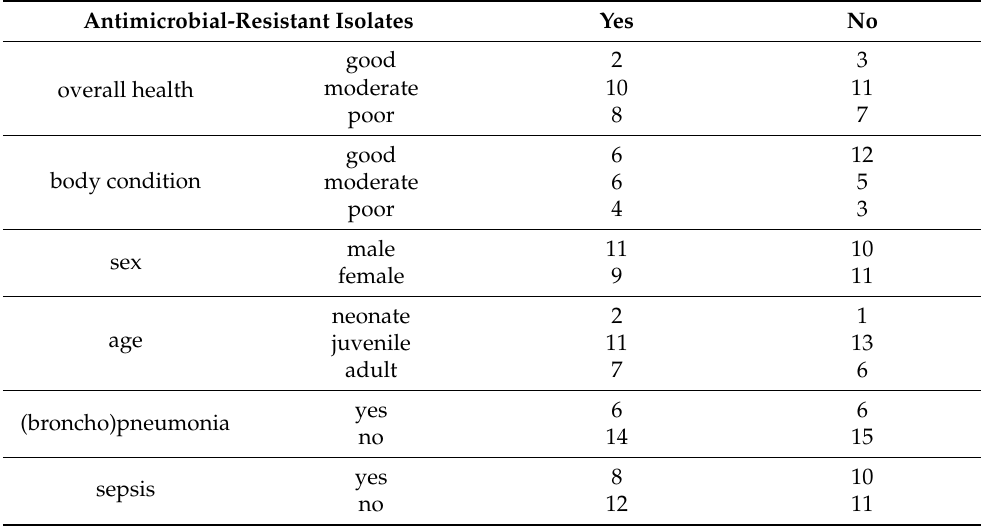
Table 3. Antimicrobial resistance as a function of health parameters, sex and age class. Occurrence of antimicrobial resistance listed for different parameters including overall health, body condition, sex, age and the two most frequent diseases diagnosed during marine mammal necropsies ( n = 41) with 20 animals harbouring antimicrobial-resistant E. coli . Antimicrobial-Resistant